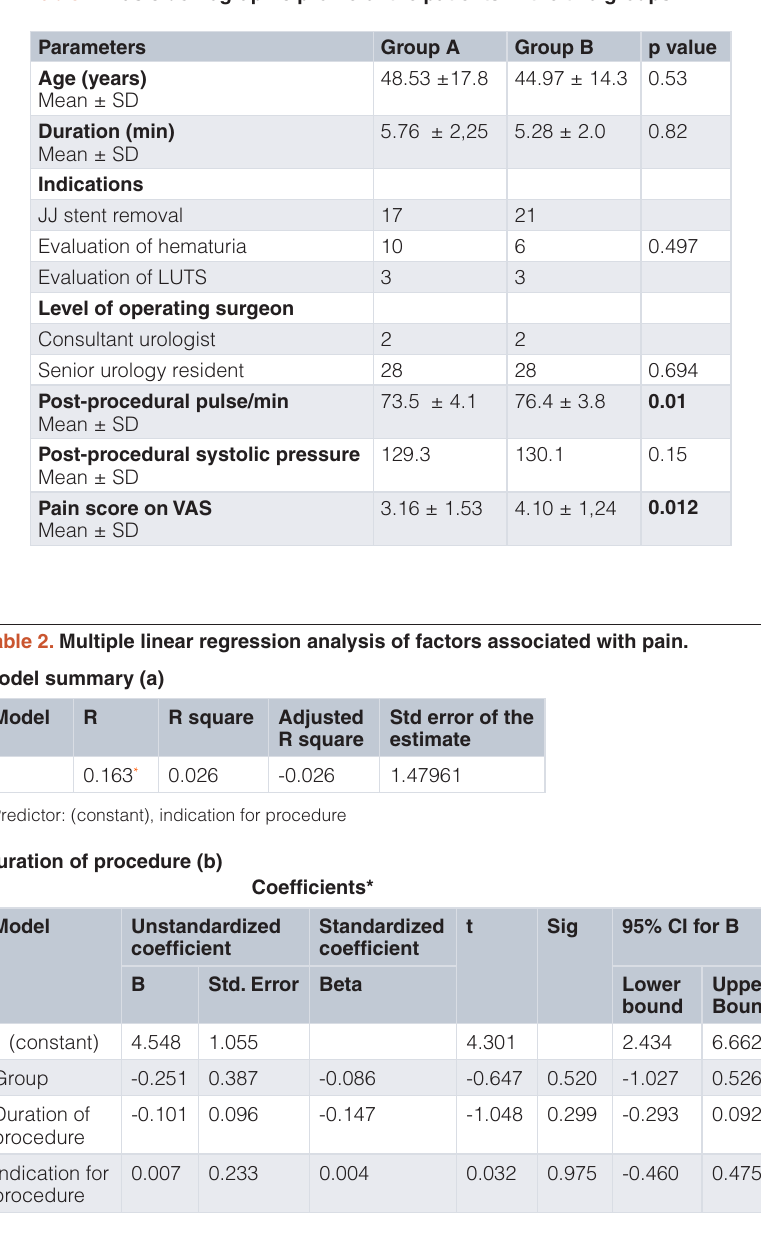
Table 1. Basic demographic profile of the patients in the two groups.